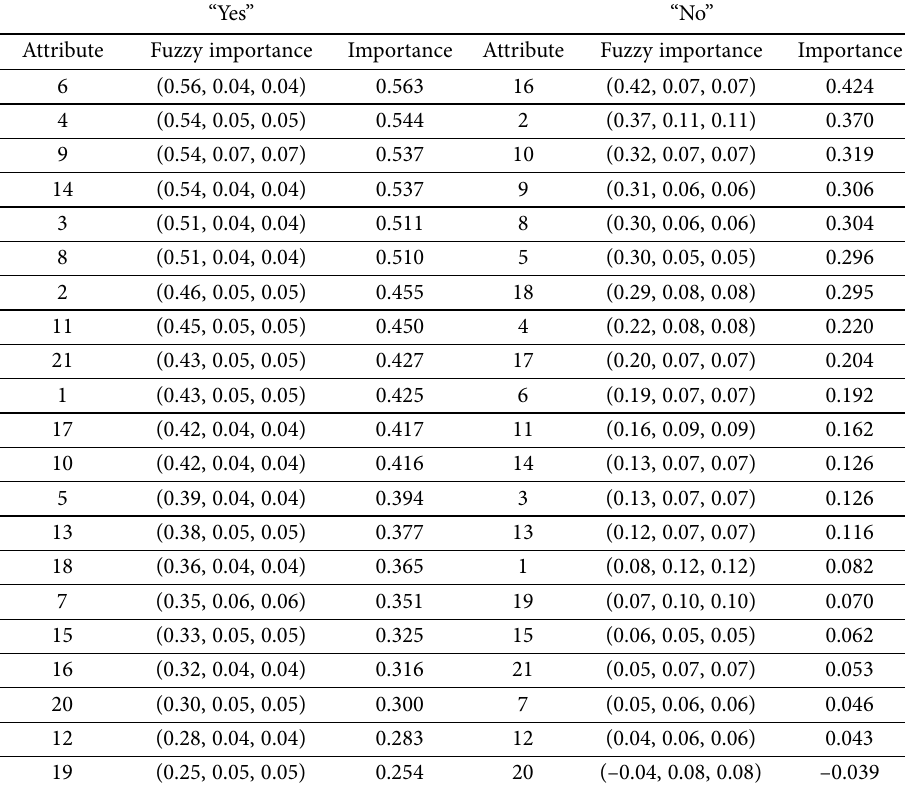
Table 11. Fuzzy importance and crisp importance of attributes related with the experience – All